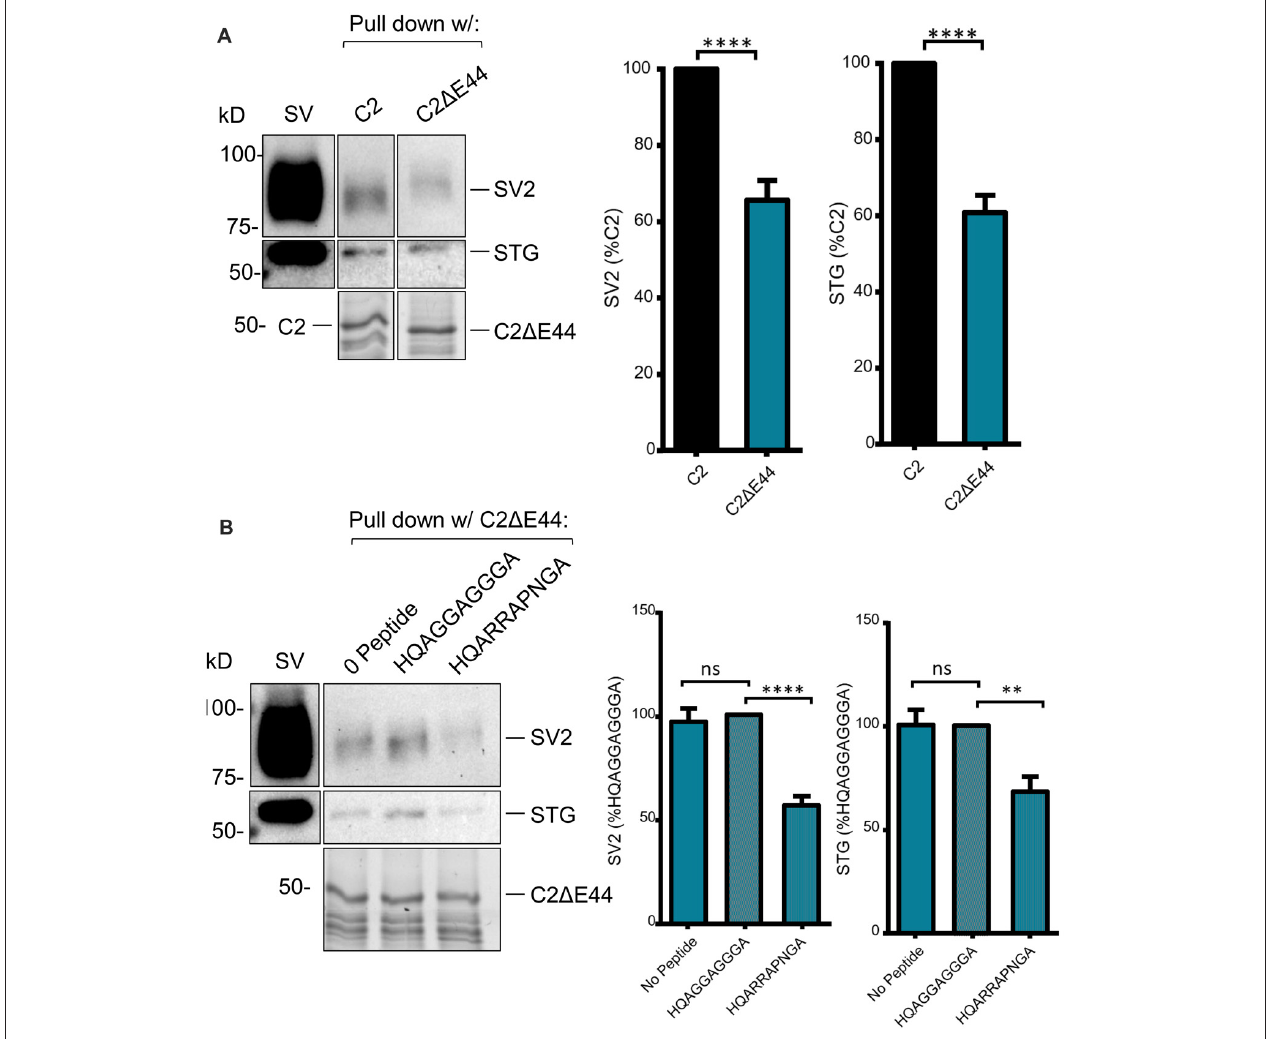
FIGURE 5 | SV-PD with the C2 ∆ E44 mutant C2 fusion protein. (A) Left panel : SV-PD with the C2 ∆ E44 fusion proteins. Right panel : histograms comparing SV or STG protein band intensity for the two fusion proteins. ∗∗∗∗ p < 0.0001. (B) Left panel : The (+)xxRR motif blocking peptide HQARRAPNGA reduced but did not eliminate SV-PD using the C2 ∆ E44 fusion protein. Right panel : histogram comparing SV2 or STG protein band intensity for no peptide, control peptide and blocking peptide conditions. ∗∗ p < 0.01; ∗∗∗ p < 0.001; ns p >